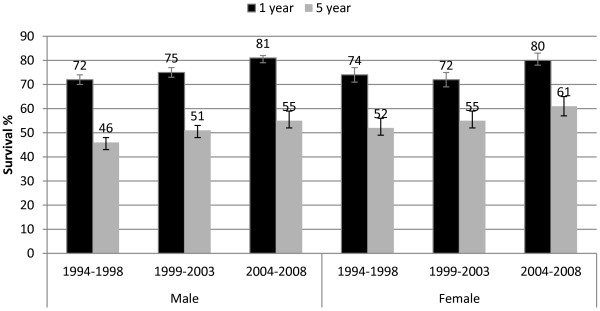
One and five year relative survival for rectal cancer by diagnostic period by sex, with 95% confidence intervals.